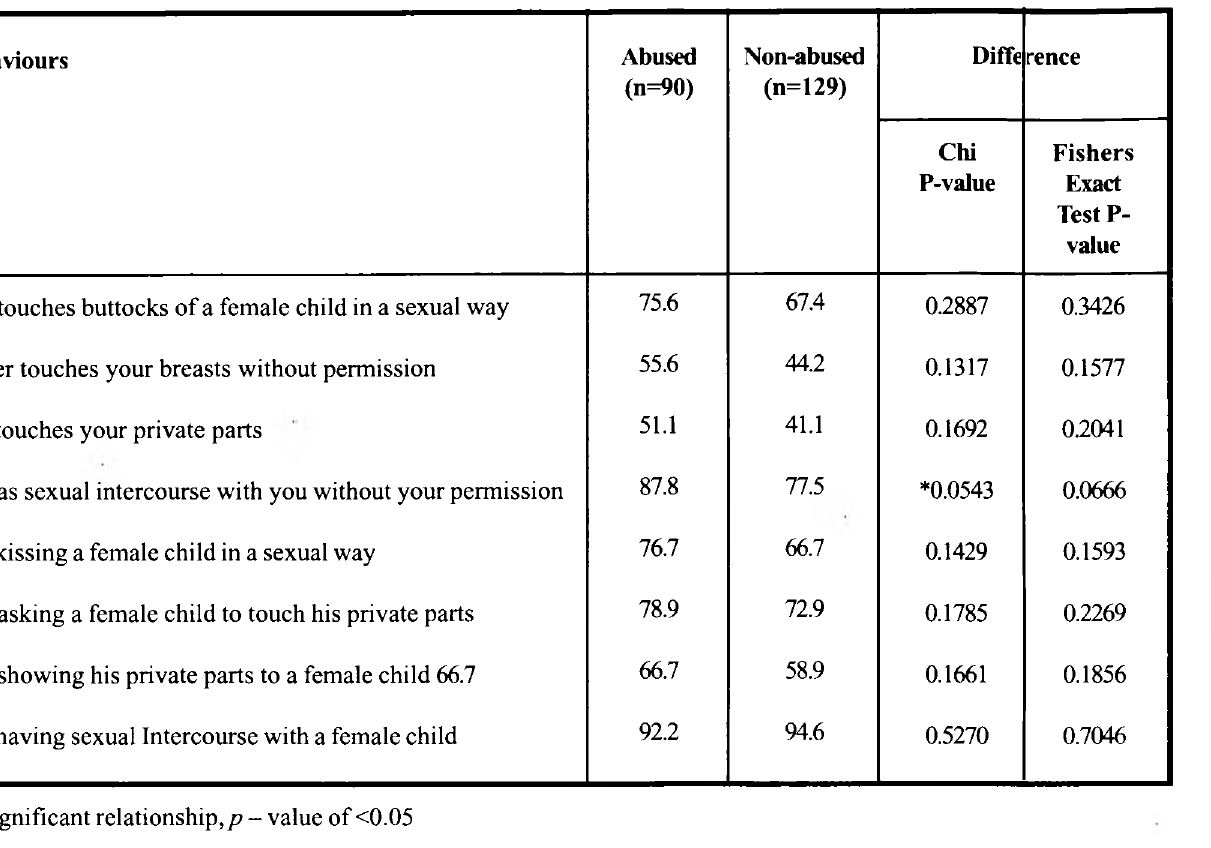
TABLE 2. Knowledge of sexual abuse; abused compared to non-abused (n=219)